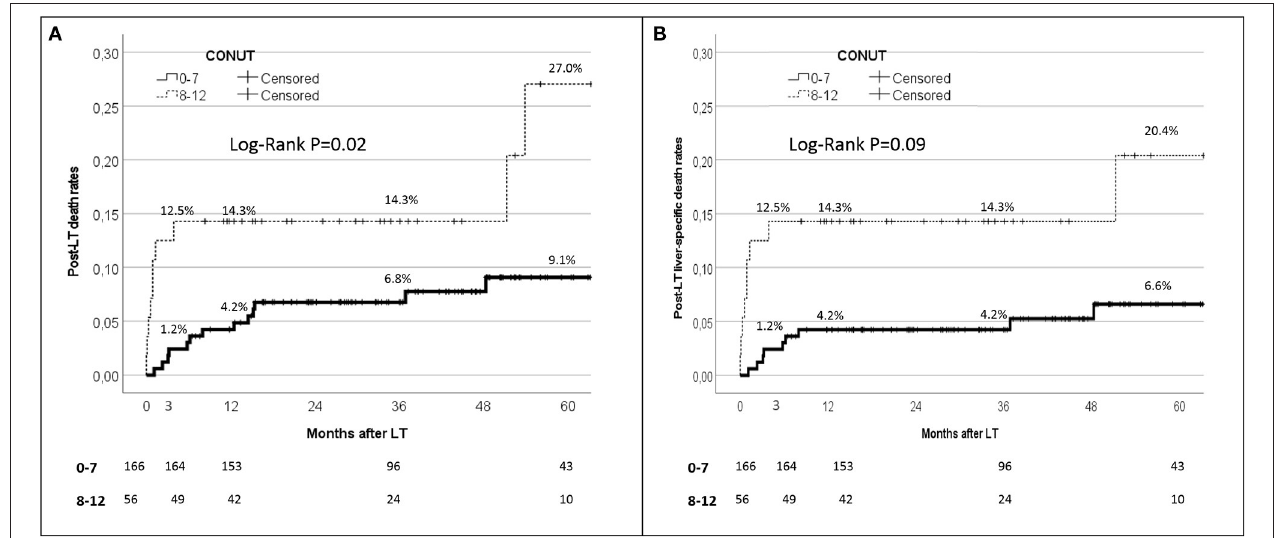
FIGURE 4 | Kaplan-Maier analysis for the 90-day patient survival rates in patient initially with CONUT 0–7 vs